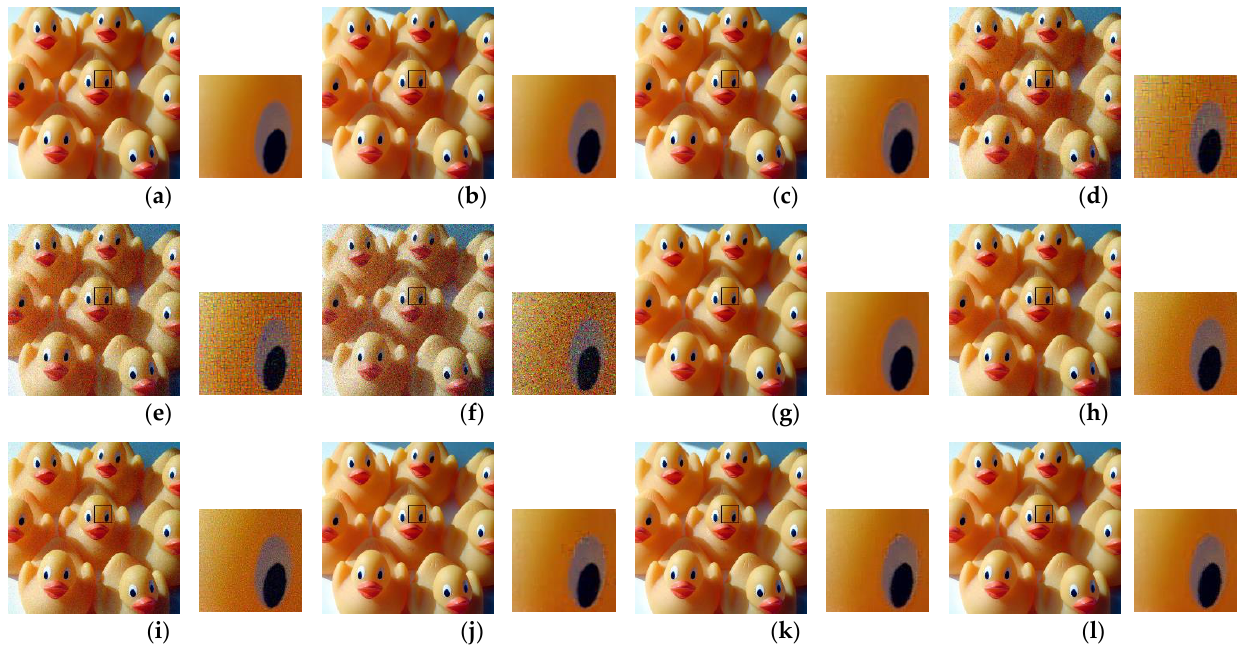
Figure 9. Images recovered from PE methods using different block sizes. The JPEG quality factor is 71. ( a ) The original image. ( b ) Image recovered from the plain image. ( c – f ) Images recovered from the Color–EtC method with block sizes (16 × 16, 8 × 8, 4 × 4, and 2 × 2), respectively. ( g – i ) Images recovered from the GS–EtC method with block sizes (8 × 8, 4 × 4, and 2 × 2), respectively. ( j – l ) Images recovered from the proposed with block sizes (8 × 8, 4 × 4, and 2 × 2), respectively. The boxed region in each image is zoomed in and shown on its left